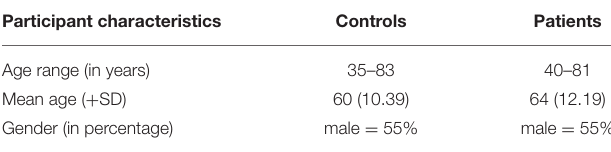
TABLE 1 | Characteristics of the participants. Participant characteristics